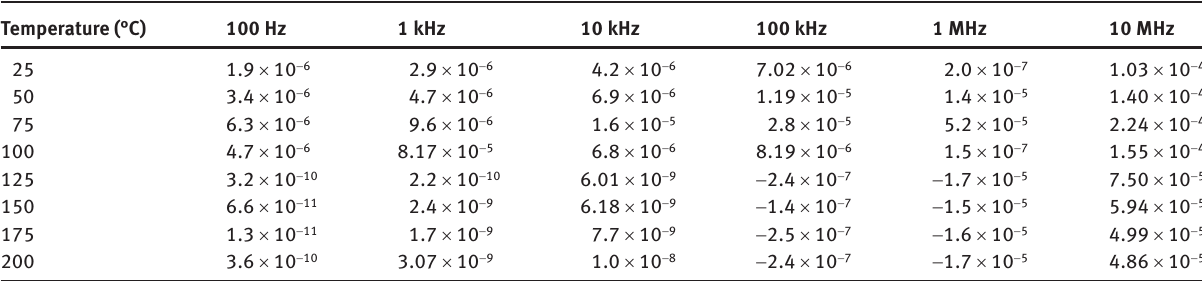
Table 2: Temperature scans and AC conductivity (S/cm) at various frequencies of the ECTW. Temperature (°C)